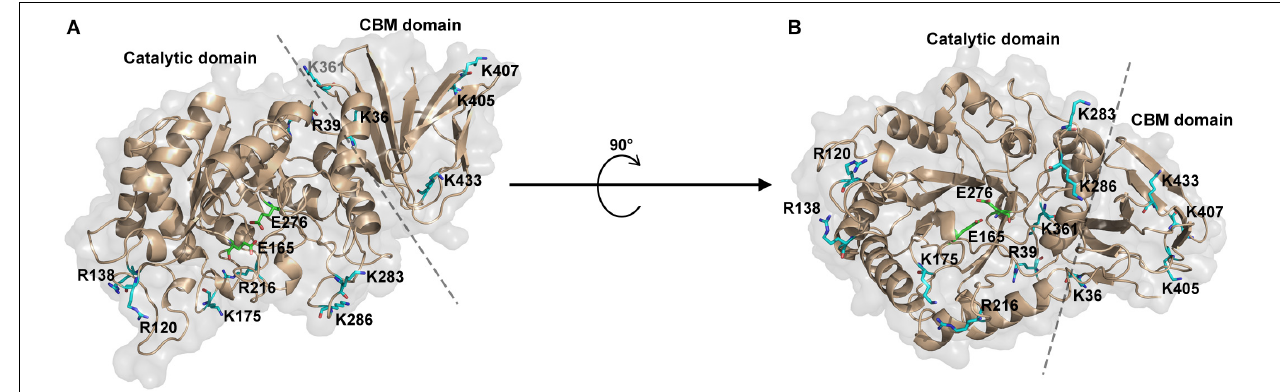
FIGURE 2 | Representation of potential trypsin cleavage sites. (A,B) The structure of PslG is shown in cartoon and surface modes. The catalytic domain and carbohydrate-binding domain (CBM) are separated by a dashed line. Surface residues related to trypsin proteolysis are shown in sticks and colored as blue. The key catalytic residues (E165 and E276) of PslG are shown in stick and colored as green.